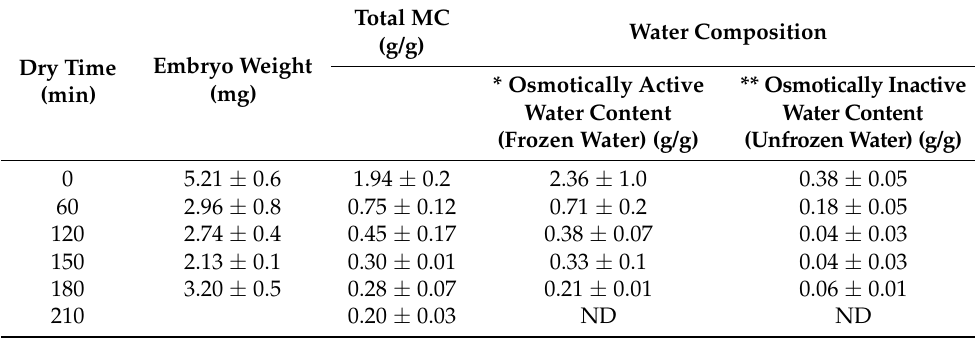
Table 3. The effect of desiccation time (0–210 min), embryo weight (mg), total moisture content (MC) and water content (frozen and unfrozen water) of Syzygium maire embryonic axes